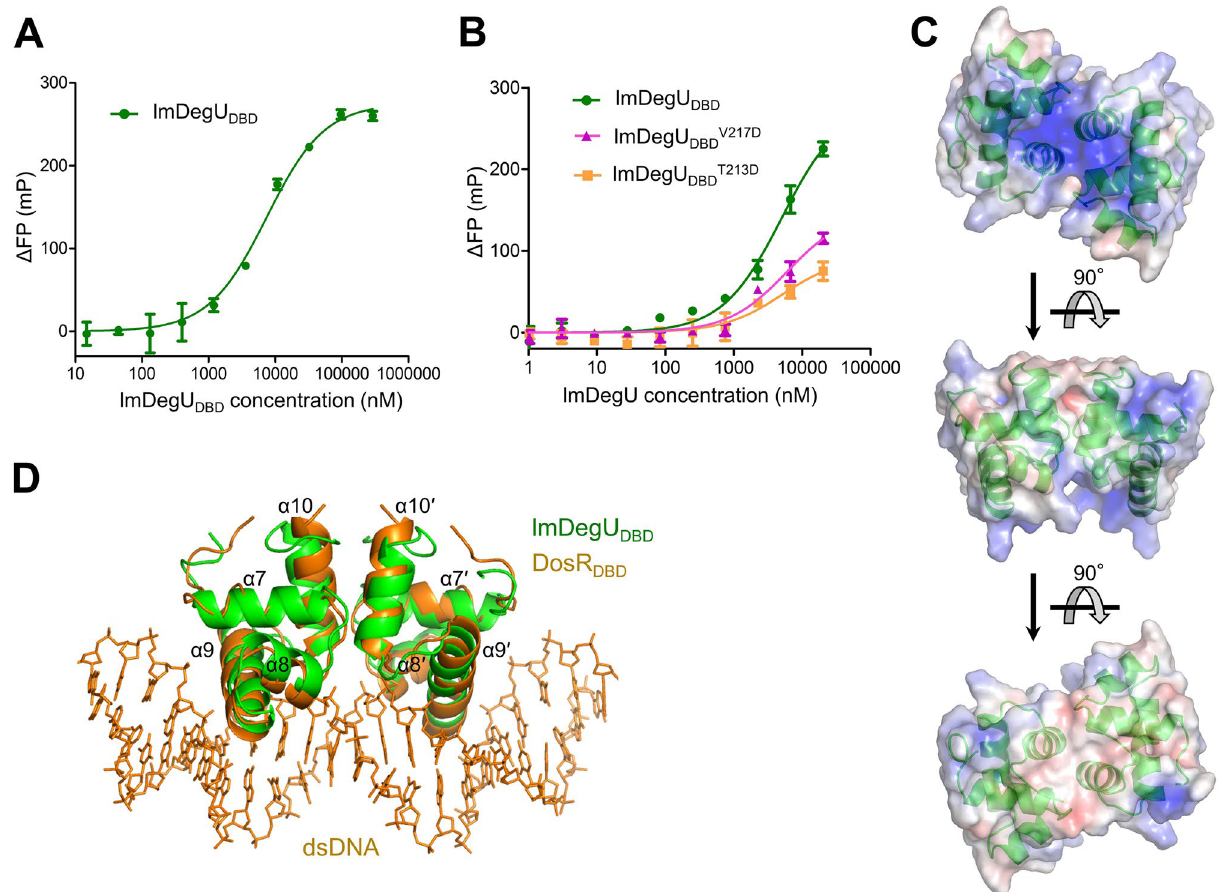
Figure 3. DNA binding by lmDegU DBD . ( A ) Operator dsDNA-binding affinity of lmDegU DBD based on the FP assay. The data (means ± S.D.) are representative of four independent experiments that yielded similar results. ( B ) DNA-binding levels of lmDegU DBD and the dimerization-deficient mutants (lmDegU DBD T213D and lmDegU DBD V217D ) based on the FP assay. The data (means ± S.D.) are representative of three independent experiments that yielded similar results. ( C ) Surface electrostatic potentials of lmDegU DBD . The lmDegU DBD dimer structure is shown as semi-transparent electrostatic potential surfaces (positive, blue; neutral, white; negative, red) with ribbons (green). The orientation of lmDegU DBD in the middle panel is identical to that in Fig. 2A. ( D ) Overlay of the lmDegU DBD dimer structure (green ribbons) on the DosR DBD -dsDNA complex structure (DosR DBD , orange ribbons; dsDNA, orange lines; PDB ID 1ZLK) 24 . The orientation of the lmDegU DBD dimer in the figure is identical to that in the middle panel in ( C